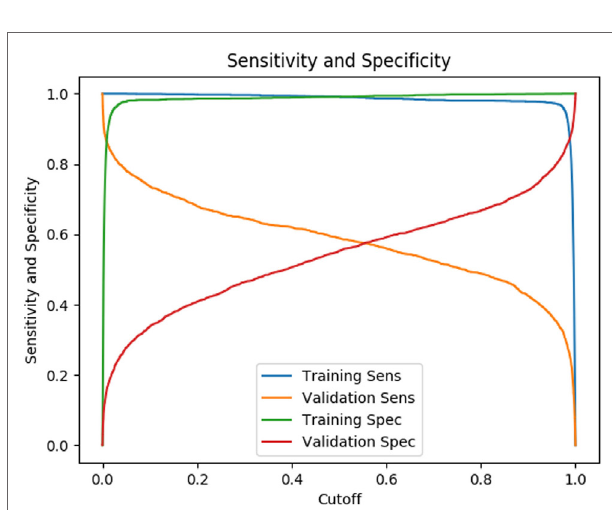
FigUre 5 | Training and validation accuracy is shown for the training data for 120 epochs. Blue line corresponds to training accuracy and orange line corresponds to validation